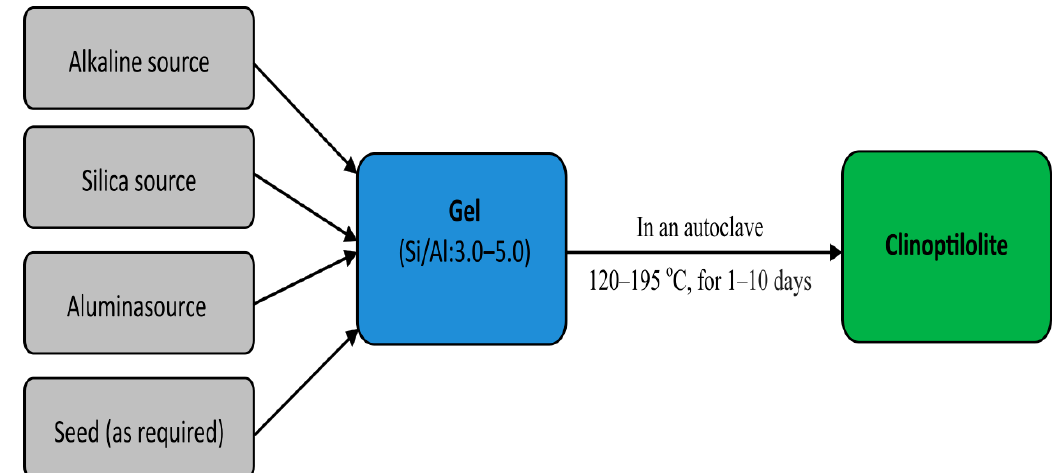
Figure 1. Schematic representation of the synthesis of clinoptilolite.